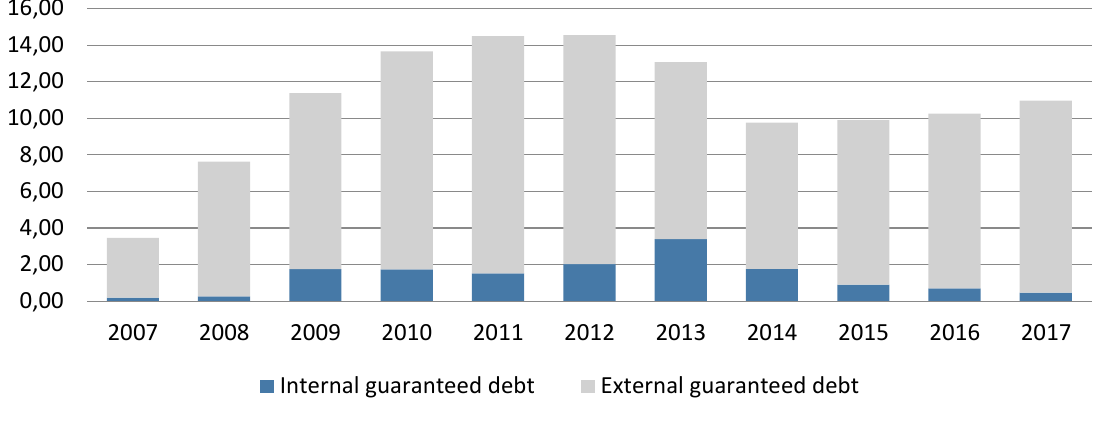
Figure 8. State-guaranteed debt of Ukraine, USD billion